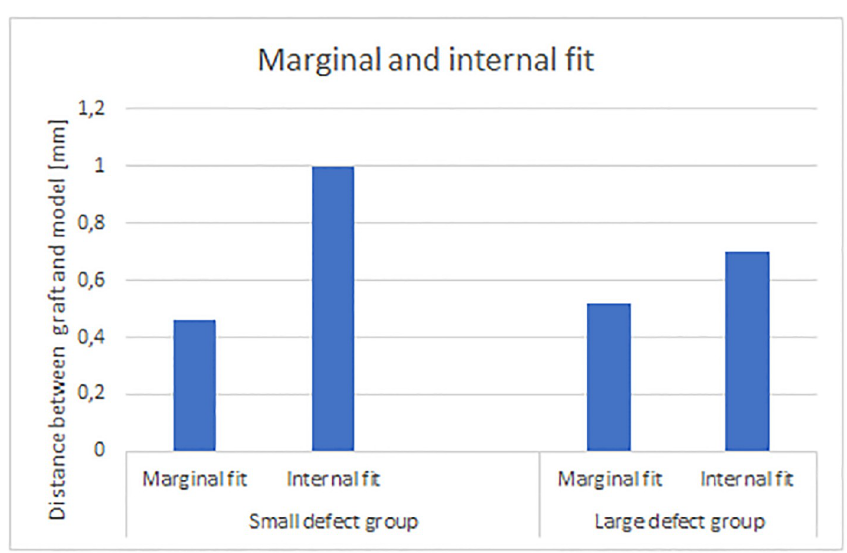
Fig 6. Marginal and internal fit. Bar chart presenting mean marginal and internal distances between grafts fitted on the recipient site of the alveolar ridge models. Values represent the means, n = 6.